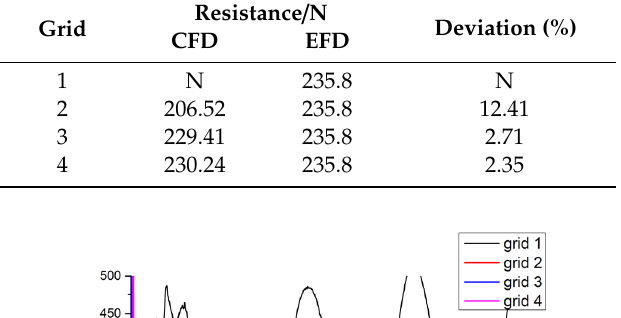
Table 5. Numerical results of four grids. CFD, computational fluid dynamics; EFD, experimental fluid dynamics.